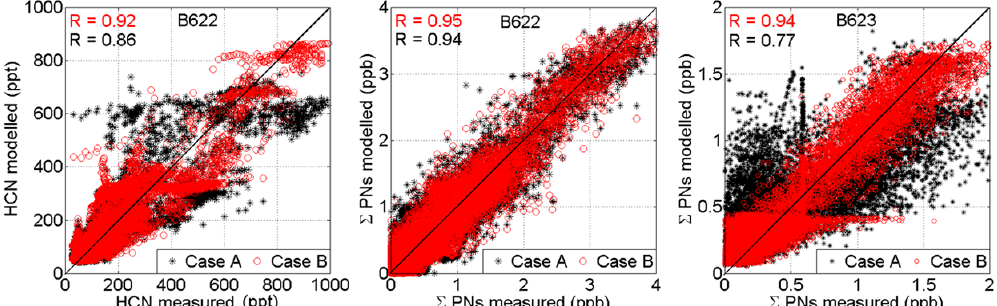
Figure 7. Scatter plots (from left): HCN modelled vs. HCN measured (cases A and B) for flight B622; P PNs measured vs. P PNs modelled (cases A and B) for flight B622; P PNs measured vs. P PNs modelled (cases A and B) for flight B623.